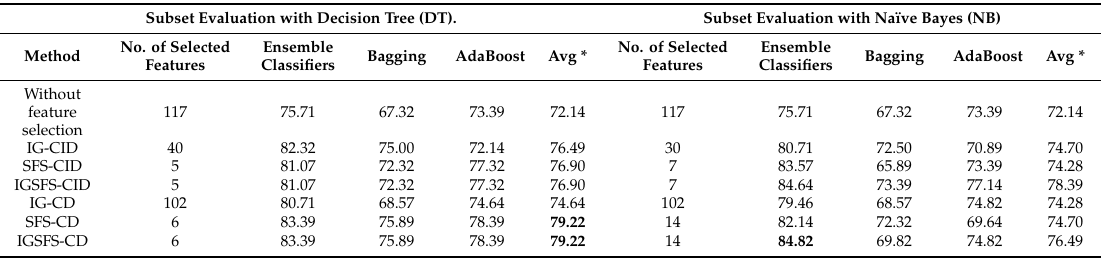
Table 7. Comparison of classification accuracy (%) using ensemble learning methods with LC_dataset-II. Subset Evaluation with Decision Tree (DT).